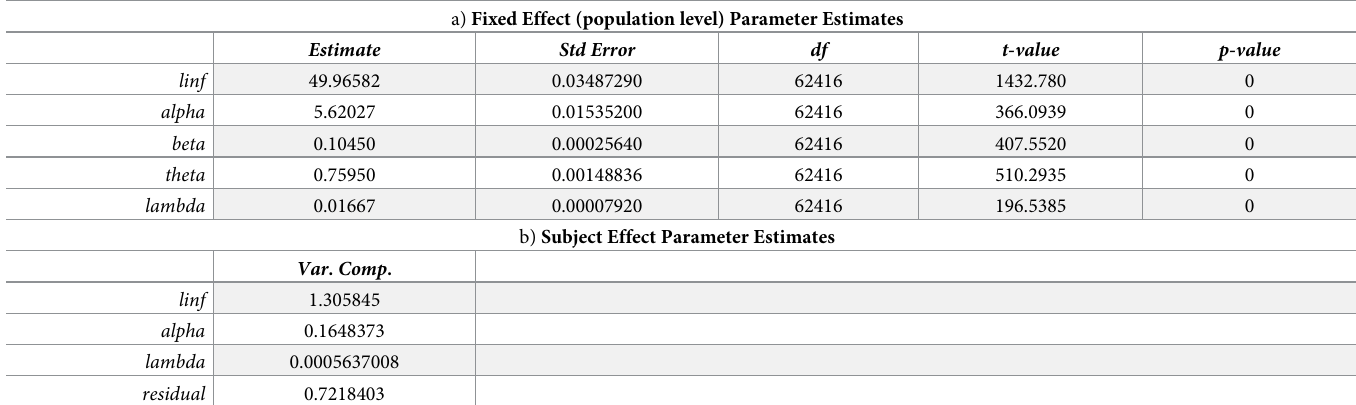
Table 10. Parameter estimates for Gompertz model with nonlinear deceleration fit to head circumference data from children between early pregnancy and earlys